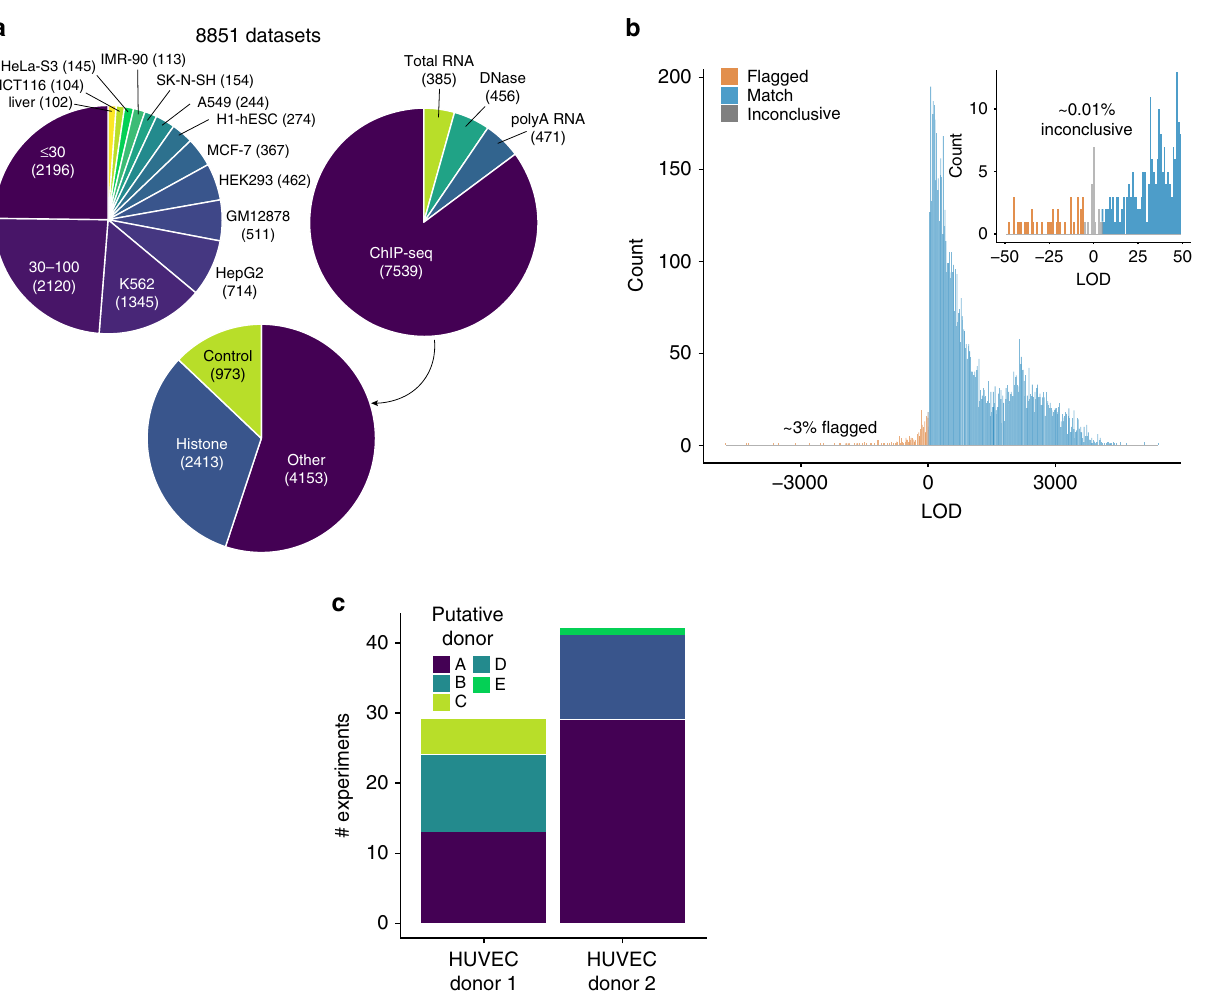
Fig. 2 Overview of ENCODE database swap detection. a Overview of 8851 genotyped datasets from ENCODE, partitioned by cell type (top left), assay type (top right), and by target for ChIP-seq (bottom). Cell types that had less than 100 datasets derived from them were pooled — so all the datasets from them are grouped into those with less than 30 datasets or those with 30-100 datasets. All hg19 aligned reads from total RNA-, polyA RNA-, ChIP-, and DNase-seq experiments performed on samples belonging to donors with at least four datasets in total were included in the analysis. All ChIP-seq targets, including histone modi fi cations (HM), transcription factors (TF), chromatin modi fi ers (CM), CTCF, and control experiments were included. b Distribution of LOD scores from ENCODE genotyping. Each dataset was compared to three representative datasets from its nominal donor. Any dataset scoring negatively against any of the three representatives was fl agged for further review. A comparison resulting in an LOD score between − 5 and 5 was deemed inconclusive (insuf fi cient evidence to indicate shared or distinct genetic origin). c Each fl agged sample was compared to all other samples from its nominal donor, as well as the representatives for all other donors in our database to nominate true donor identity and identify genetically consistent sub-clusters. Comparisons of fl agged samples between two HUVEC donors reveal fi ve genetically distinct